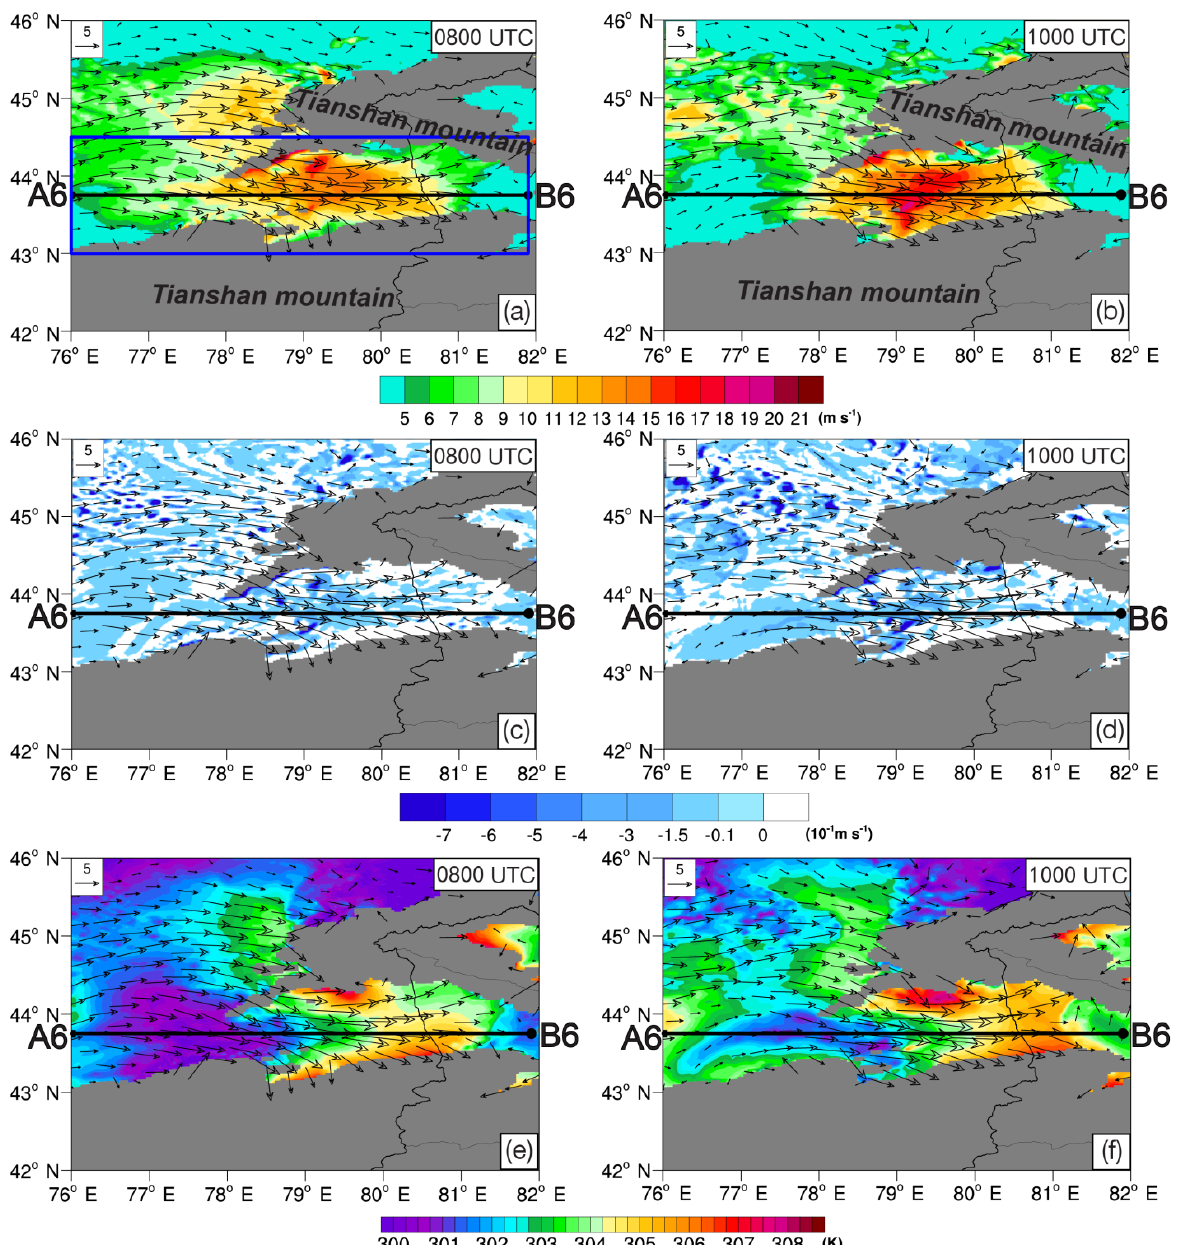
Figure 12. ( a – b ) The horizontal velocity (shading, units: m s −1 ) and wind field (vector arrows) at 1500 m (ASL) on 17 June 2016, the dark grey shadings show the area that ground surface altitude >1500 m (ASL). The black line segment A6B6 shows the location of the zonal vertical cross section (along 43.75° N) in Figure 13. The blue rectangle area shows the area for calculating the meridional-mean value of vertical vorticity in Figure 13e,f. ( c , d ) The same as ( a , b ) but for the vertical velocity (shading, units: m s −1 ). ( e , f ) The same as ( a , b ) but for the potential temperature (shading, units: K). The specific time is shown in the upper right corner of each panel.